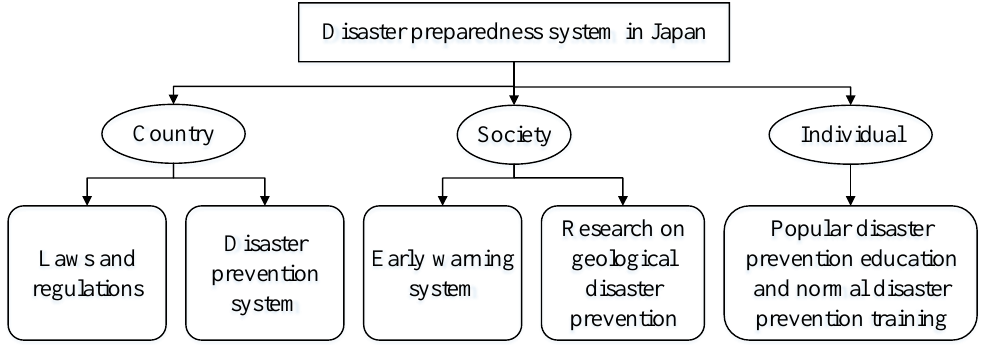
Figure 9. Disaster preparedness system in Japan.